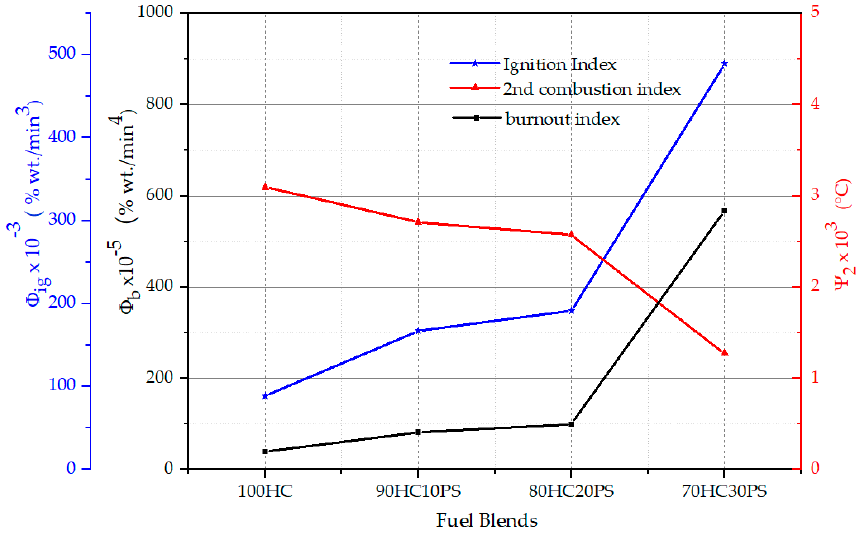
Figure 10. Ignition index, burnout index, and second combustion index at 20 °C/min heating rate under an air atmosphere.